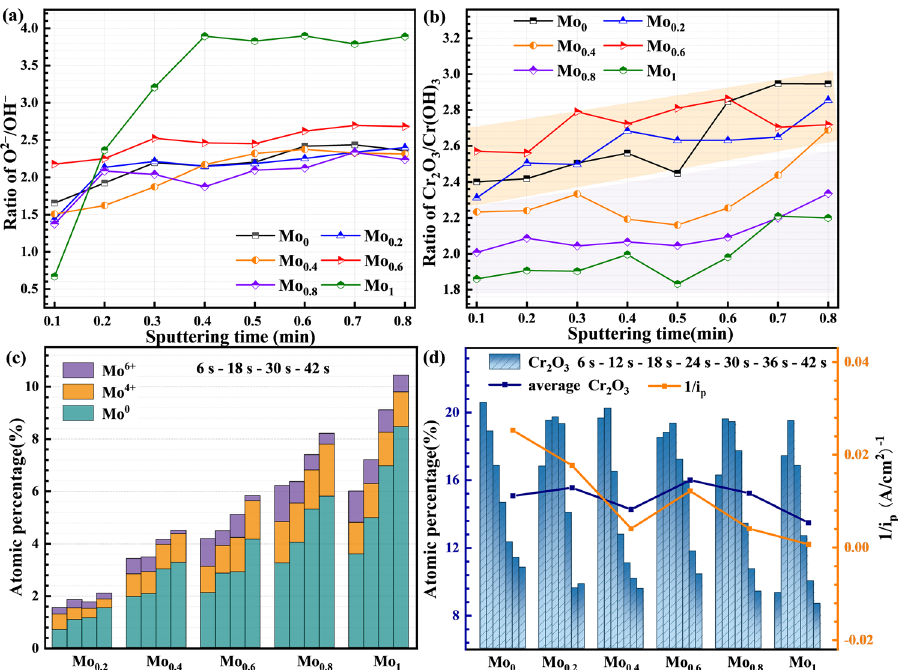
Fig. 13 Special species distribution summarized from XPS depth pro fi les. a XPS depth pro fi les of the ratio of O 2 − /OH − , b the ratio of Cr ox / Cr hy , c the atomic percentage of Mo species, d the atomic percentage of Cr 2 O 3 for the passive fi lms and reciprocal of passivation current density.